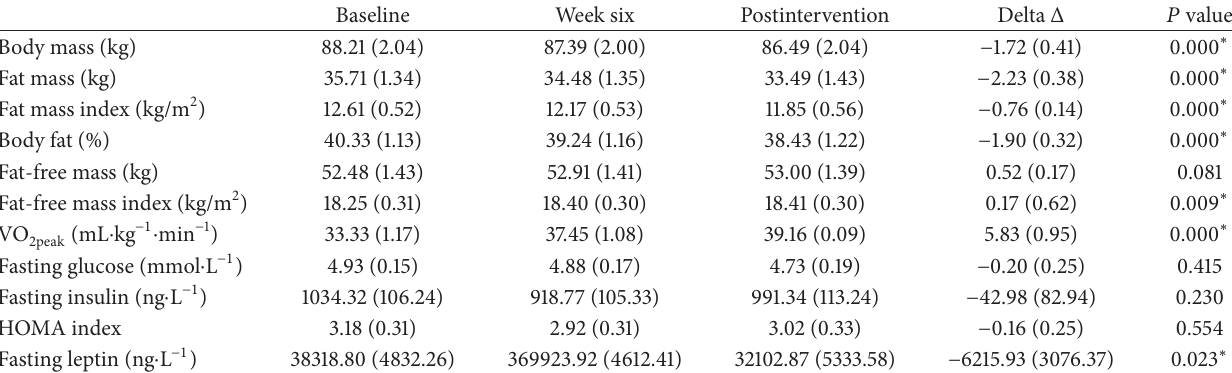
Table 1: Body composition and metabolic values during the 12-week exercise intervention ( 𝑛 = 46 ).